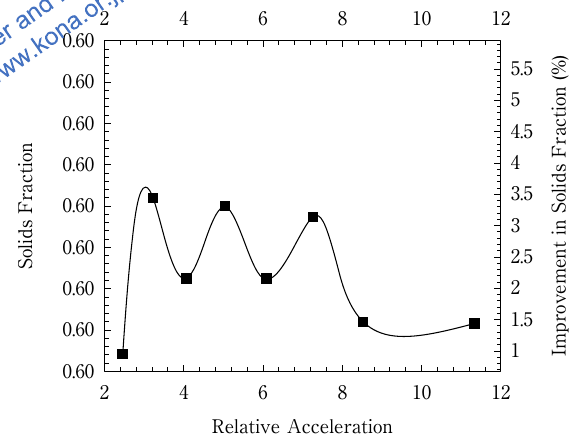
Fig. 5 Solids fraction versus relative acceleration at a/d = 0.24. The solid line is a best fit curve to show the